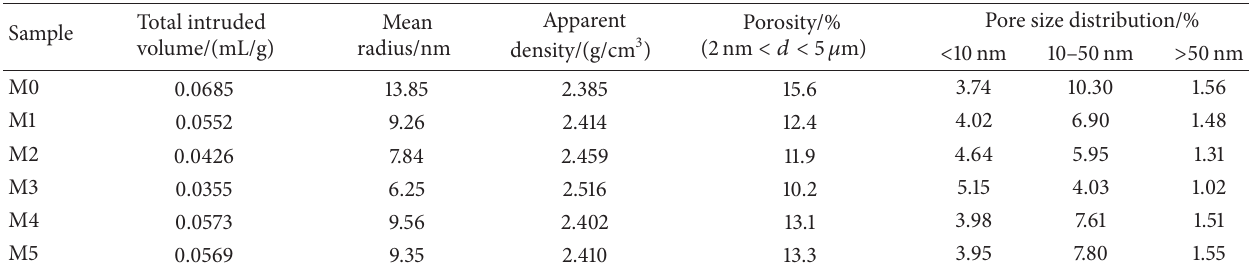
Table 4: Internal pore distributions of hardened mortars at 28 days with different dosages of NT.